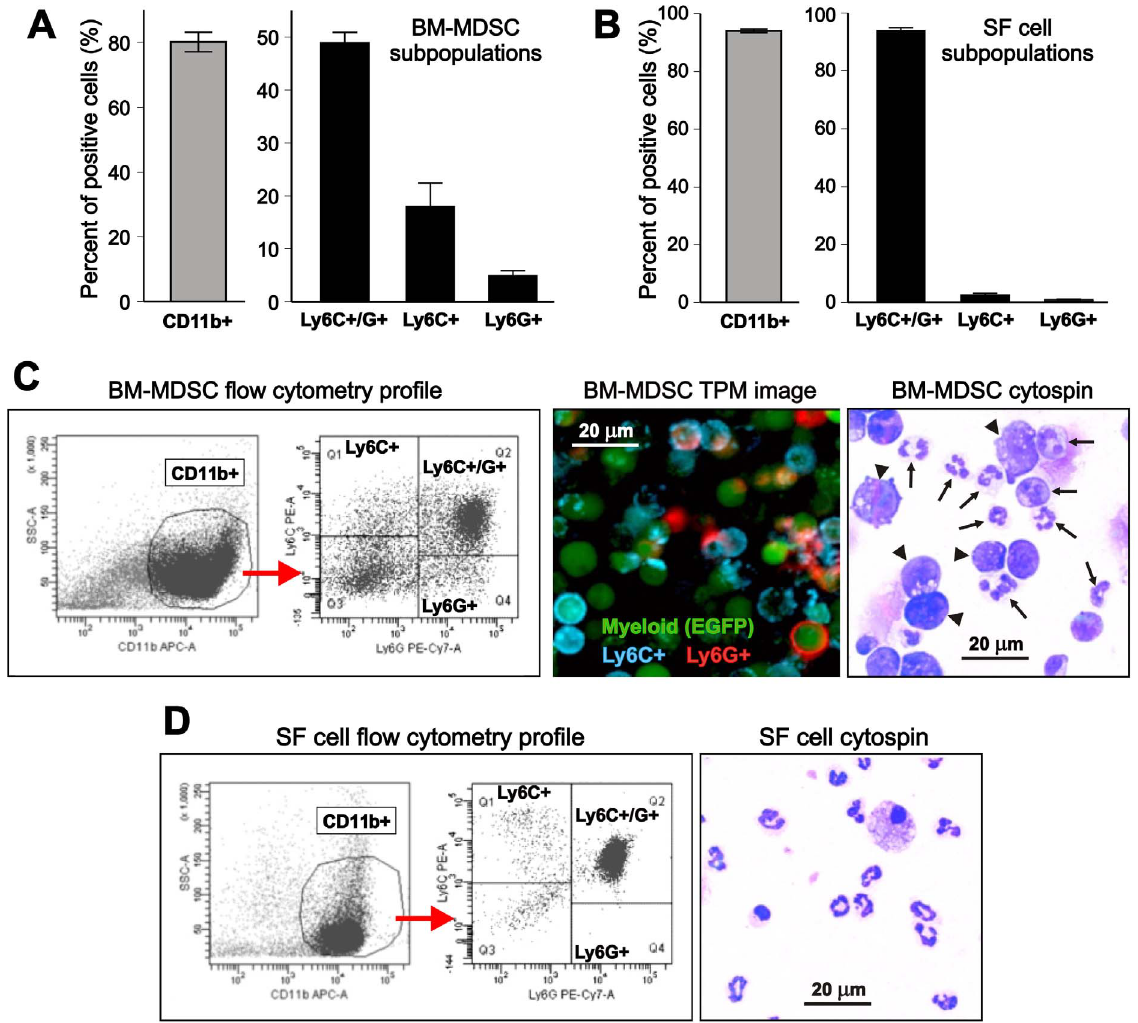
Figure 1. Phenotype and morphology of myeloid-derived suppressor cell (MDSC)-like cells generated in vitro from murine bone marrow (BM) in comparison with synovial fluid (SF) cells. ( A ) Phenotype of MDSCs arising from growth factor-cytokine treated BM cell cultures as determined by flow cytometry. BM cells were cultured in the presence of GM-CSF, IL-6, and G-CSF (10 ng/ml each). On day 3, cells were immunostained for CD11b, Ly6C, and Ly6G. Approximately 80% of the cells expressed the common myeloid marker CD11b (gray bar). Gating on CD11b + cells revealed that the majority of them co-expressed Ly6C (marker of the ‘‘monocytic’’ subset) and Ly6G (marker of the ‘‘granulocytic’’ subset), but cells expressing only one marker were also present (black bars). The results are the means 6 SEM of 7 independent BM cultures. ( B ) In SF, the vast majority of the CD11b + myeloid population (gray bar) was found to be cells co-expressing Ly6G and Ly6C, and lower proportions of cells expressed Ly6C or Ly6G only (black bars) than in the BM-MDSC cell cultures. The results are the means 6 SEM of 7 separate pools of SF cells freshly harvested from arthritic mouse joints. ( C ) Flow cytometry profile of BM-MDSCs (left panels) is shown as an example of subset identification after gating on CD11b + cells. Fluorescence image of EGFP + BM-MDSCs (middle panel) after surface staining with a blue fluorescent antibody to Ly6C and a red fluorescent antibody to Ly6G shows cells expressing one or both markers. BM for culture was obtained from an EGFP-LysM-Tg mouse expressing EGFP (green fluorescence) in myeloid cells. Imaging was performed using two-photon microscopy (TPM). Morphology of BM-MDSCs (right panel) was visualized by Wright-Giemsa staining of a cytospin preparation, which shows both polymorphonuclear granulocyte (neutrophil)-like cells (arrows) and large precursor-like cells (arrowheads). ( D ) Flow cytometry profile (left) and morphology (right) of SF cells harvested from the arthritic joints of mice with PGIA. While the CD11b + myeloid population is large in both the BM-MDSC culture and arthritic SF, and is dominated by Ly6C/Ly6G double positive cells in both samples (analyzed simultaneously), BM-MDSCs show greater heterogeneity in morphology than SF